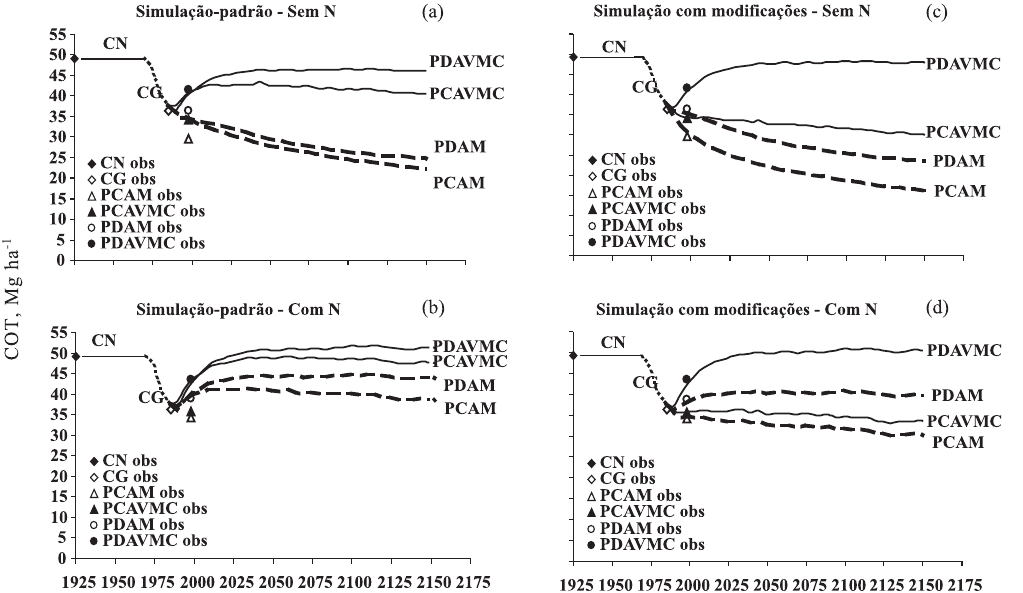
Figura 1. Evolução temporal dos estoques de carbono orgânico total (COT) do solo nas simulações-padrão sem N mineral (a) e com aplicação de N mineral (b) e nas simulações com modificações sem N mineral (c) e com aplicação de N mineral (d) estimada pelo modelo Century 4.0 para os sistemas de preparo de solo e sistemas de culturas, comparada aos dados apresentados por Lovato (2001) para os anos de 1985 e 1998. CN: campo nativo; CG: colza/girassol; PC: preparo convencional; PD: plantio direto; A: aveia;